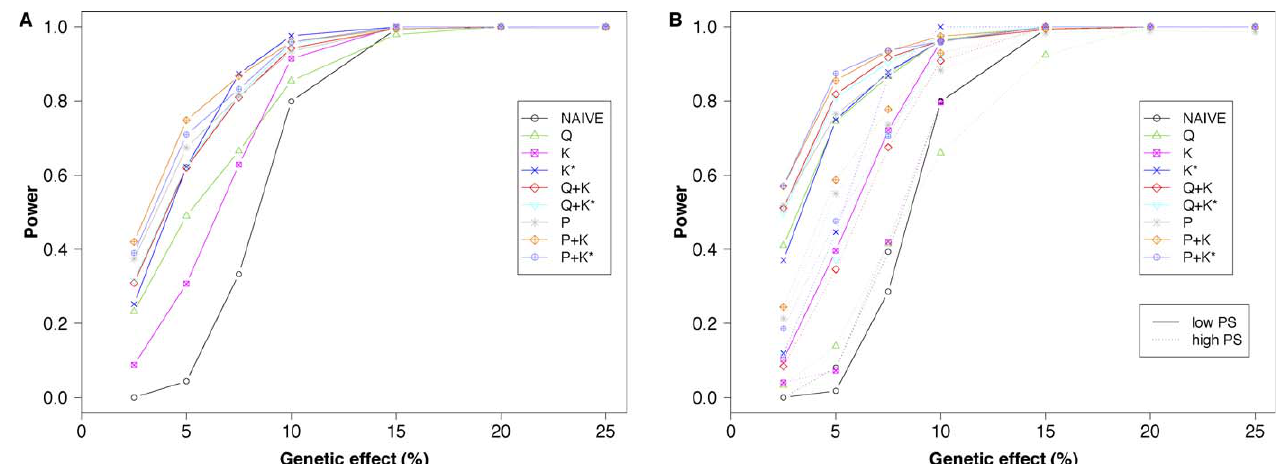
Figure 3. Power of the Different Methods to Detect a QTN The power of the different methods to detect a QTN using a 5% significance level (based on the observed distribution of p -values), as a function of the fraction of the phenotypic variation attributable to the QTN. (A) Power averaged across all simulated QTN. Methods that reduce confounding more effectively have better power. (B) Power calculated separately for QTN that showed strong correlation with population structure ( ‘‘ high PS, ’’ arbitrarily defined as simulations where more than 50% of the phenotypic variation could be explained by Q (note that ‘‘ P ’’ performs better than ‘‘ Q ’’ largely because of this definition) and those that did not ( ‘‘ low PS ’’ ). All methods are relatively powerless to detect QTN that are strongly correlated with population structure. Results for haplotypes were similar (Figure S3).